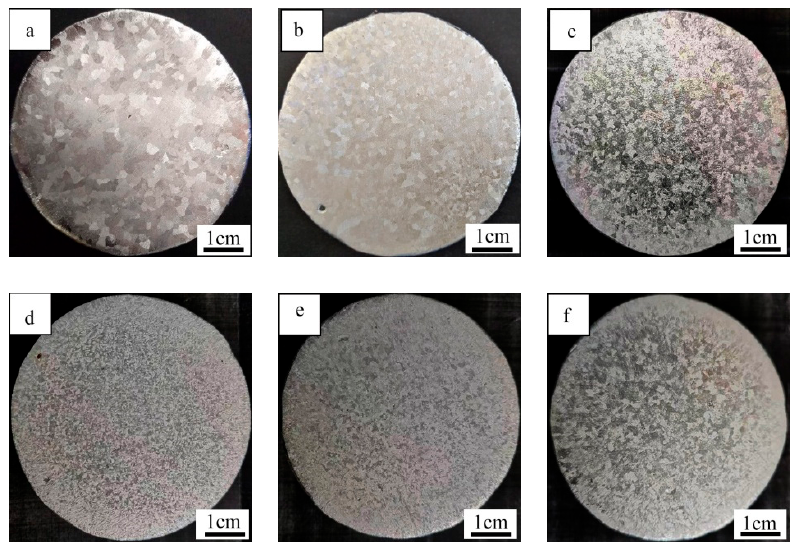
Figure 7. Macrographs of the industrial aluminum refined by Al-TiO 2 -C-XLa 2 O 3 refiners. ( a ) No refiner; ( b ) X = 0; ( c ) X = 0.1; ( d ) X = 0.2; ( e ) X = 0.3; ( f ) X = 0.4.